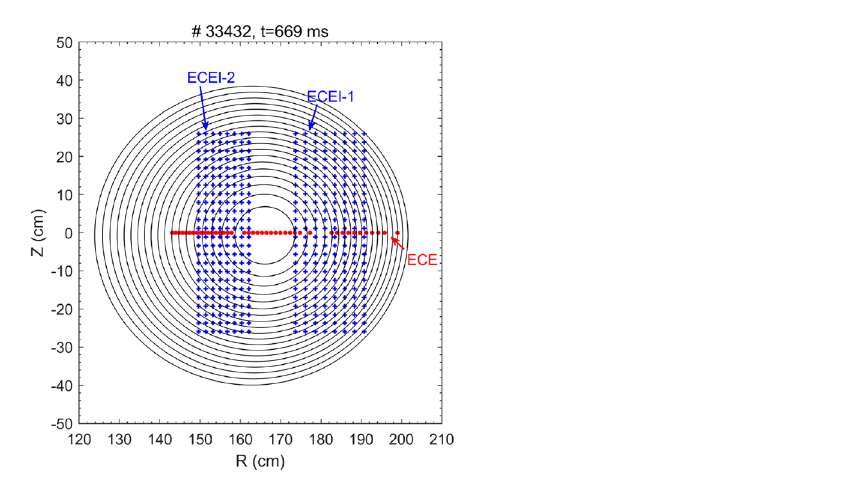
Figure 1. Measurement points of two ECEI arrays and the ECE diagnostic. The black circles denote the magnetic flux surfaces at t = 669 ms in shot